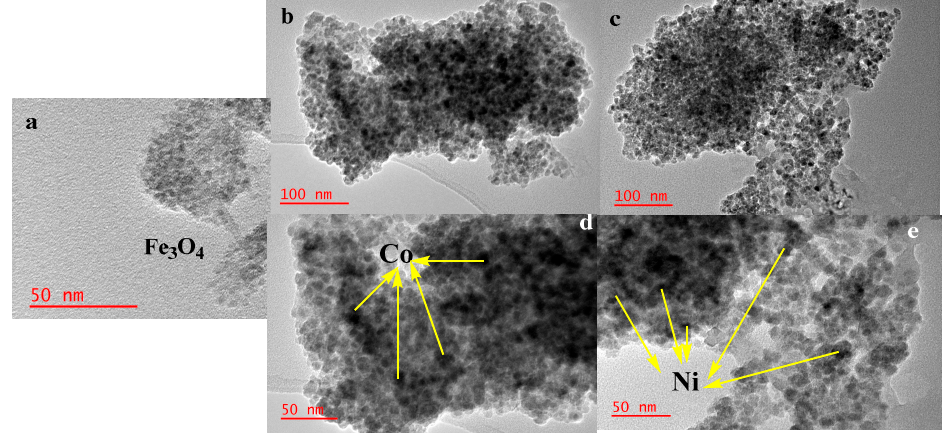
Figure 3. TEM micrograph of Fe 3 O 4 ( a ), Fe 3 O 4 @C1 ( b , d ) Fe 3 O 4 @C2 ( c , e ), respectively.